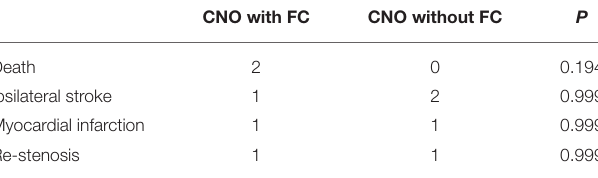
TABLE 3 | 12-month primary endpoints and incidence of